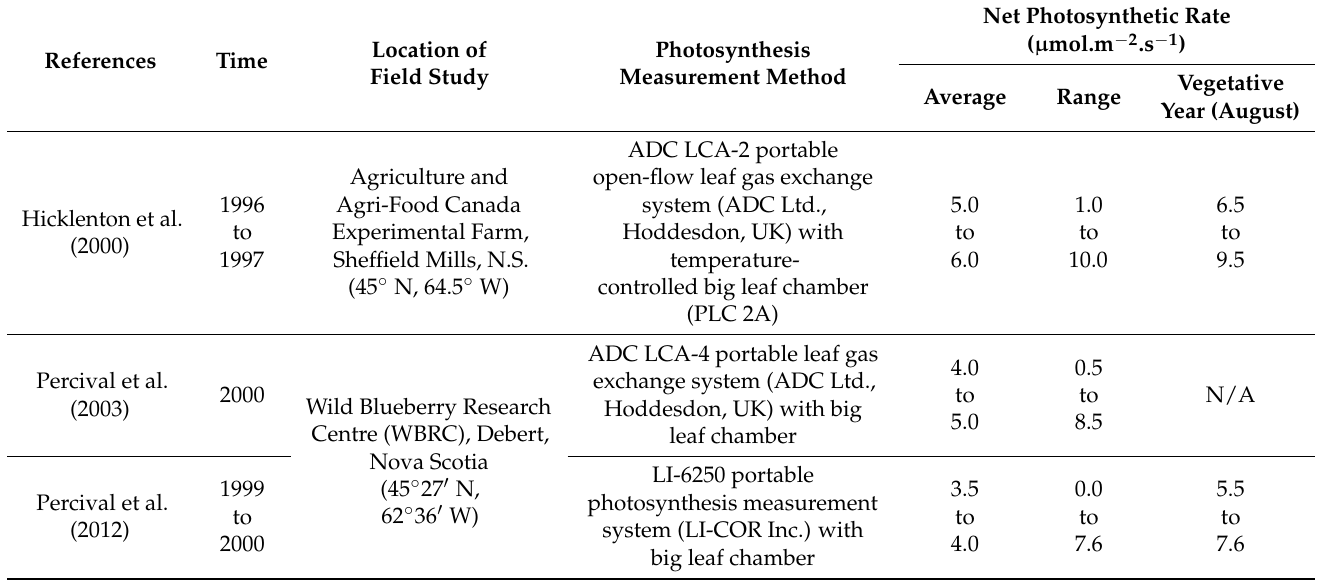
Figure 1. Measuring leaf photosynthesis in wild blueberry plants ( Vaccinium angustifolium ) using ( a ) Li-Cor big leaf chamber (10 cm 2 ; Model Li-Cor 6400-22L) and ( b ) Li-Cor small leaf chamber (2 cm 2 ; Model Li-Cor 6400-40). Table 1. Summary of leaf photosynthesis rates reported for lowbush wild blueberry crop ( Vaccinium angustifolium ) from previous field investigations.